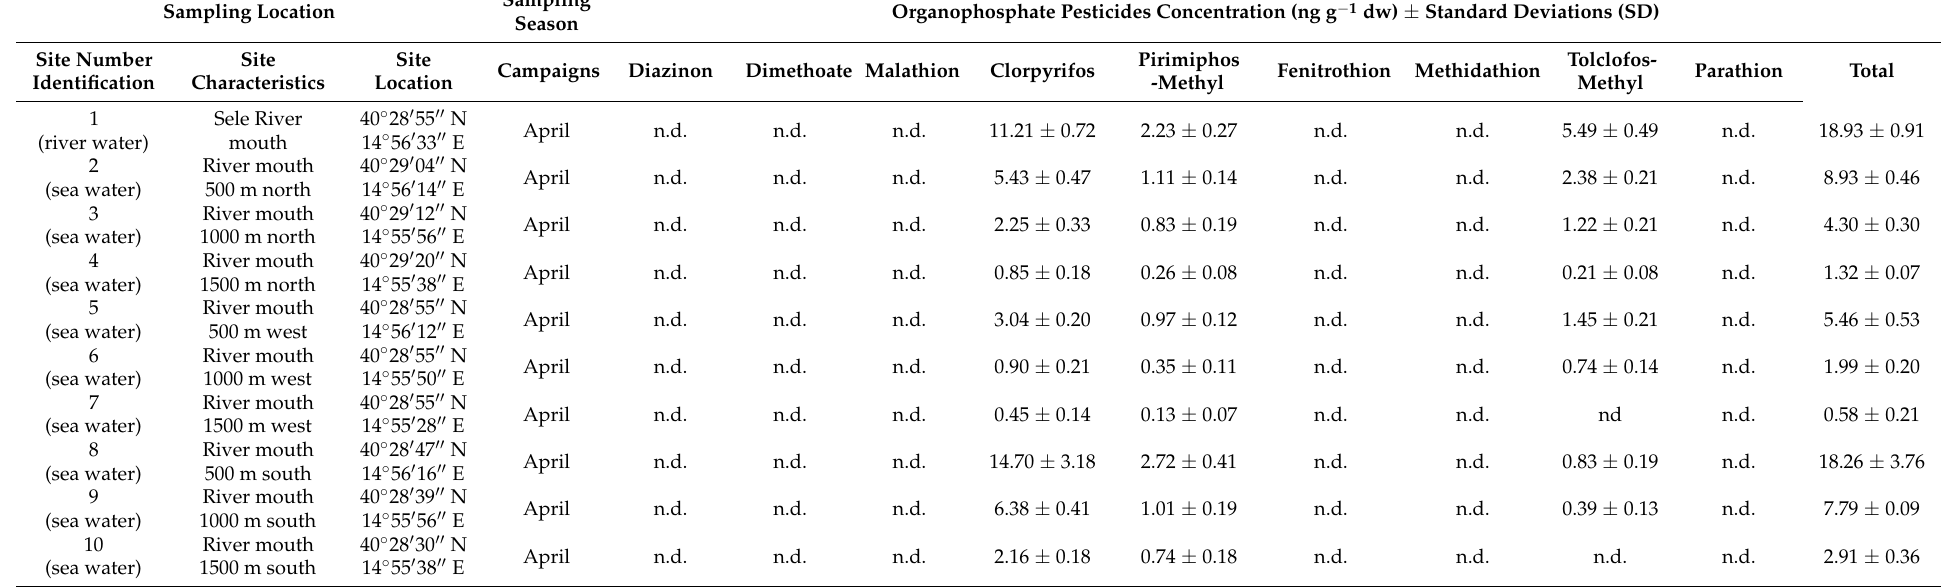
Table 4. Description of sampling sites and OPP concentration with standard deviations (SD) detected in the sediment samples (SED) (ng g − 1 dw) of Sele River, southern